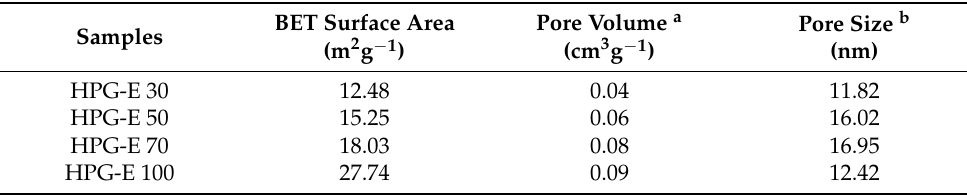
Table 6. N 2 gas adsorption-desorption analyses of the as-prepared samples.